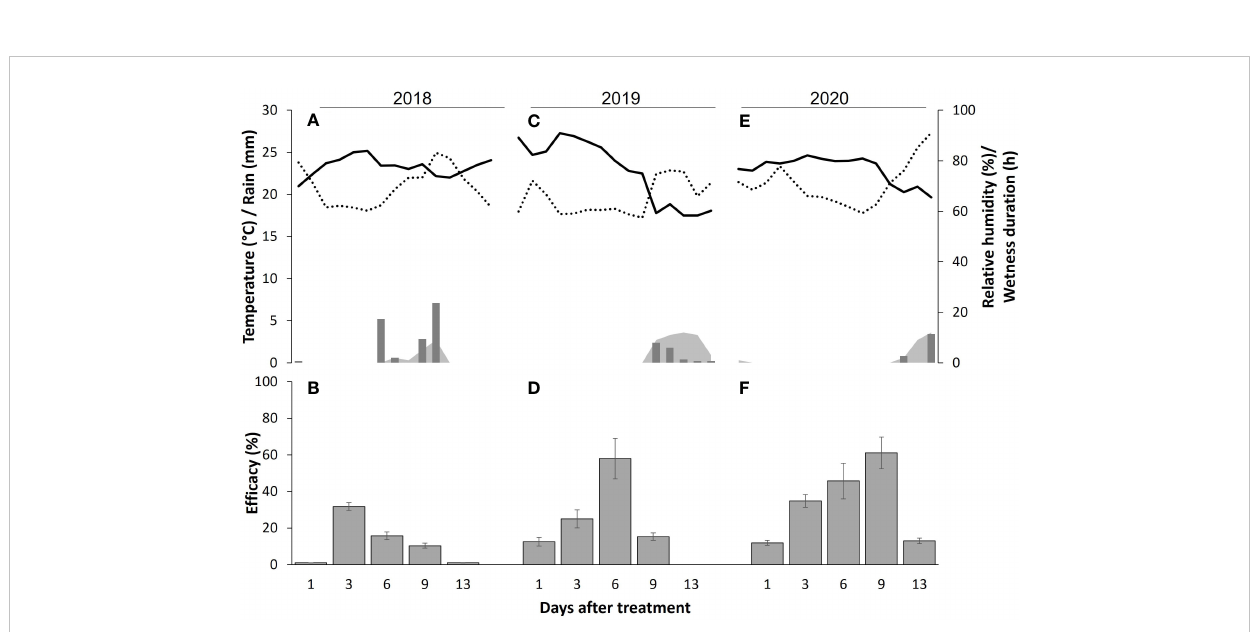
FIGURE 3 Environmental conditions (upper panel) and ef fi cacy (lower panel). Upper panel: weather conditions recorded in the experimental vineyard in 2018 (A) , 2019 (C) , and 2020 (E) . Daily values of temperature (solid line), relative humidity (dotted line), rain (bars), and wetness duration (gray area) between the day of treatment with biocontrol agents (BCAs) and the following 13 days are shown. Lower panel: Ef fi cacy (%) of treatments in 2018 (B) , 2019 (D) , and 2020 (F) with commercial BCAs in reducing gray mold in ripe grapevine berries at 1 to 13 days after treatment (DAT). Bars are means of eight BCAs and whiskers are standard errors. Ef fi cacy was calculated in relation to an untreated control for berries treated in the vineyard sampled at different DAT, arti fi cially inoculated with a conidial suspension of Botrytis cinerea in the laboratory, and then incubated under optimal conditions for the pathogen for 1 week before disease severity assessment. The year × DAT interaction was signi fi cant at P < 0.001 and accounted for 28.1% of the total variance in disease severity; the year × treatment × DAT interaction was not signi fi cant (P =